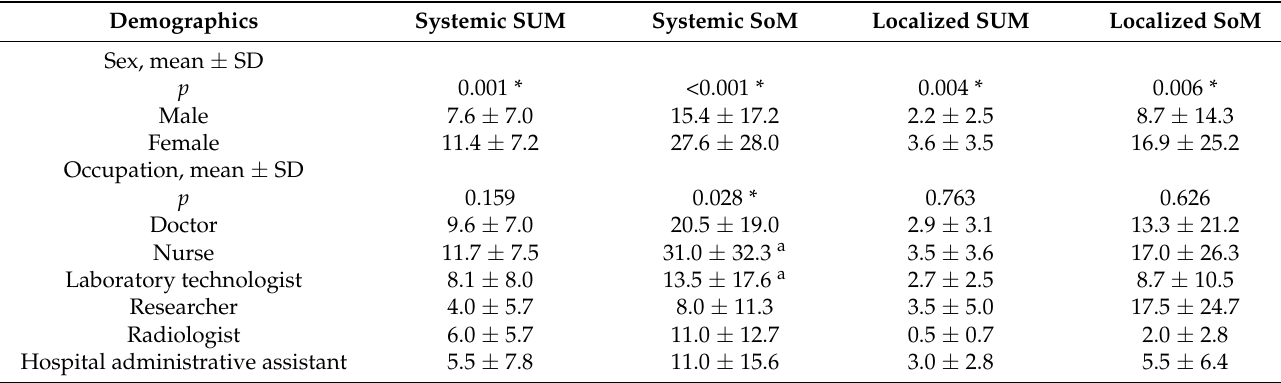
Table 2. The association between demographics and vaccine adverse